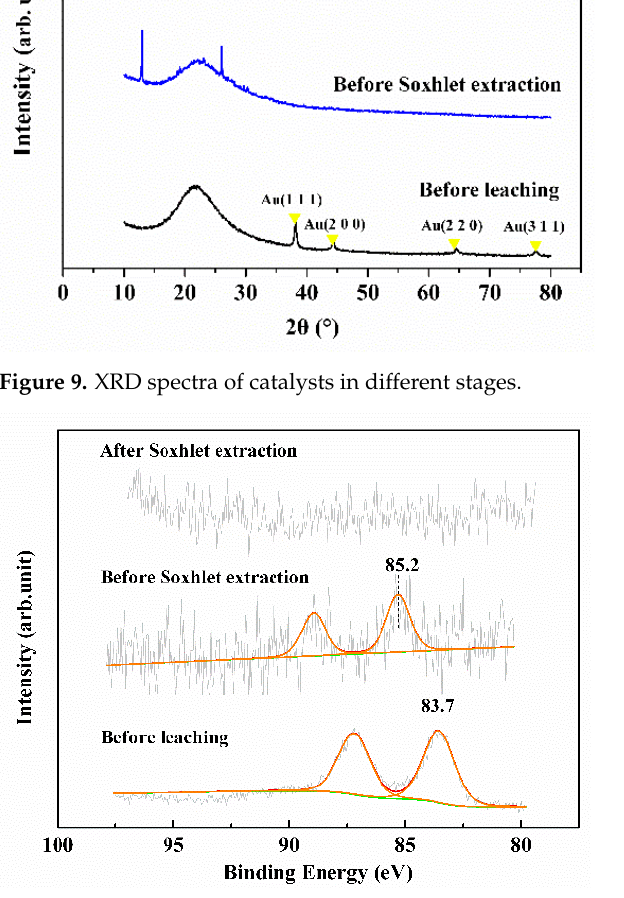
Figure 9. XRD spectra of catalysts in different stages.